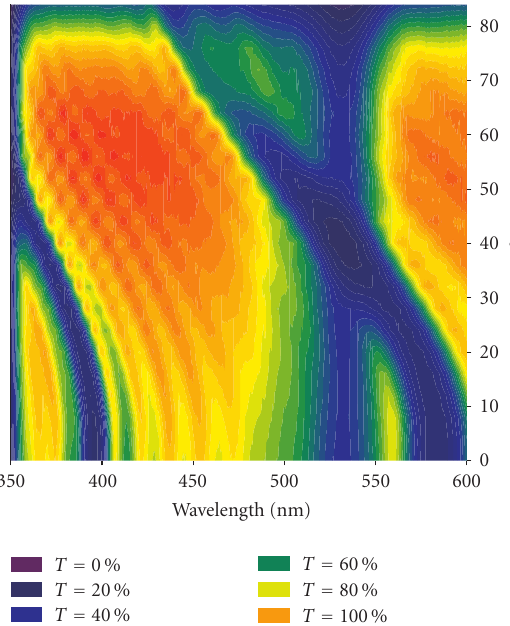
Figure 4: Incidence angle dependence of the transmission spec- trum of the dye-doped 1D